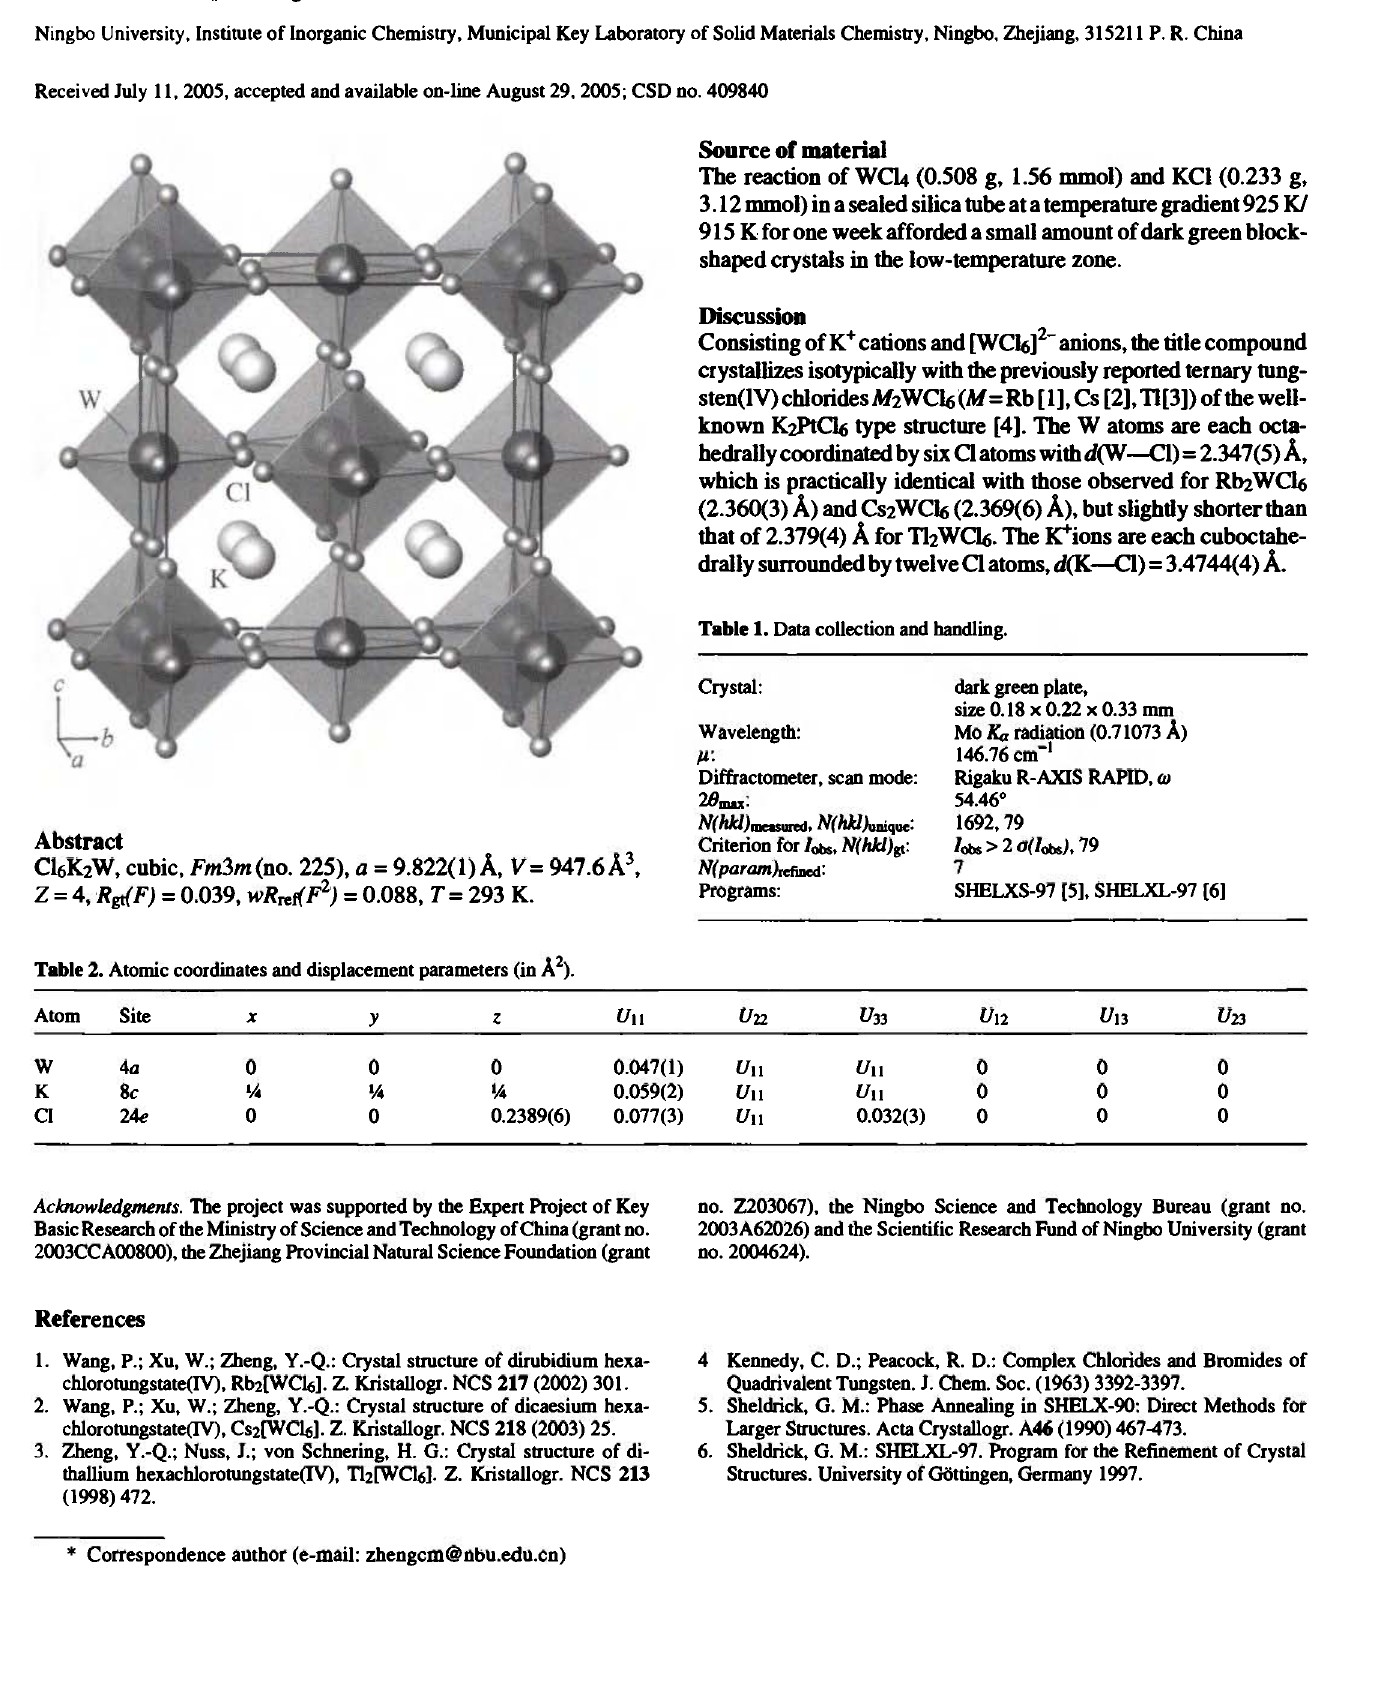
Table 2. Atomic coordinates and displacement parameters (in A 2